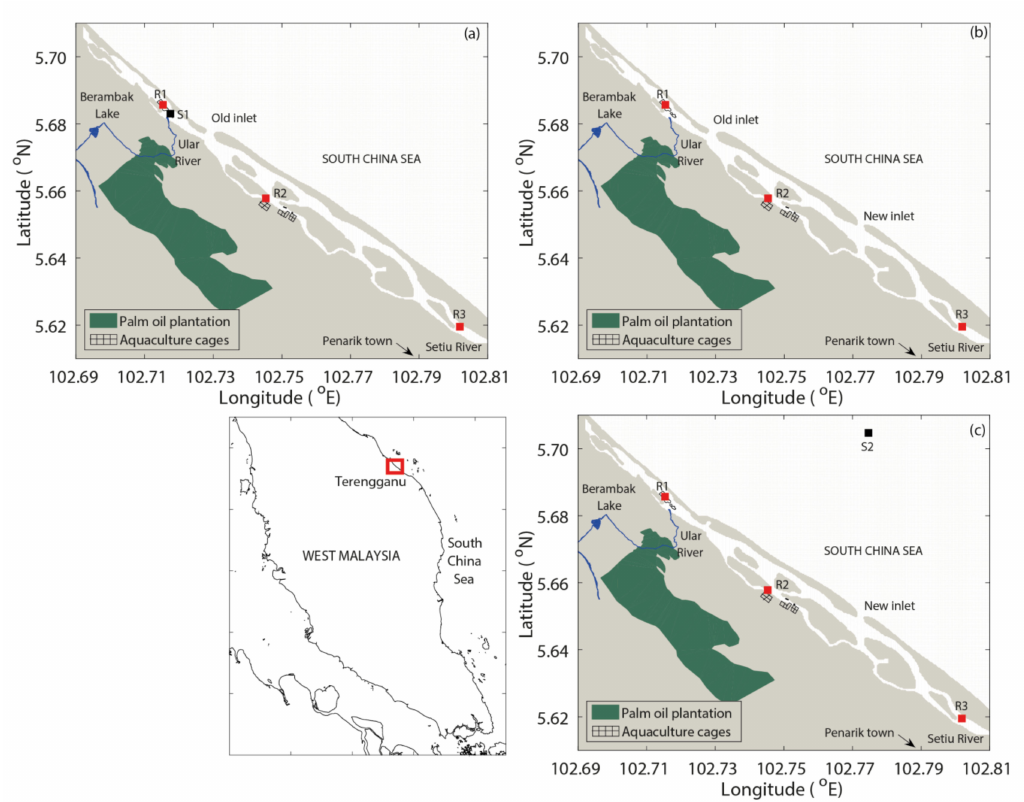
Figure 2. Map of Setiu Wetland showing a narrow lagoon, which is located in the state of Terengganu, Malaysia. The lagoon receives freshwater from the Setiu River and Berambak Lake (connected through the Ular River). The green patch indicates the palm oil plantation area, while the grids represent the aquaculture cages. S1 indicates the current meter deployment position in 2015, and S2 indicates the Acoustic Wave and Current (AWAC) profiler deployment location in 2020. R1, R2, and R3 indicate the release points for the tracers. The study area refers to three different inlet configurations, namely ( a ) old inlet, ( b ) both inlets, and ( c ) new inlets, for the interpretation of the